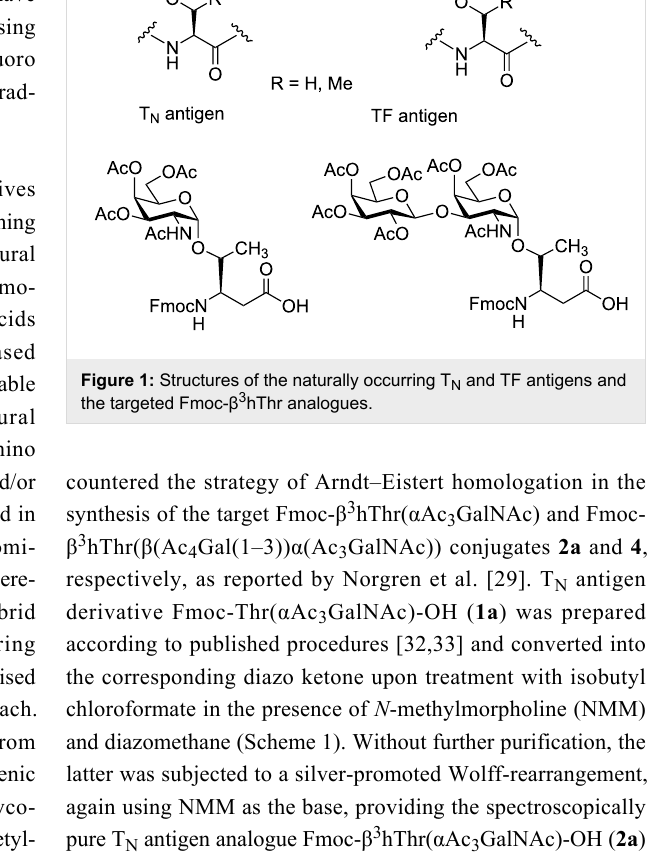
countered the strategy of Arndt–Eistert homologation in the synthesis of the target Fmoc- β 3 hThr( α Ac 3 GalNAc) and Fmoc- β 3 hThr( β (Ac 4 Gal(1–3)) α (Ac 3 GalNAc)) conjugates 2a and 4 , respectively, as reported by Norgren et al. [29]. T N